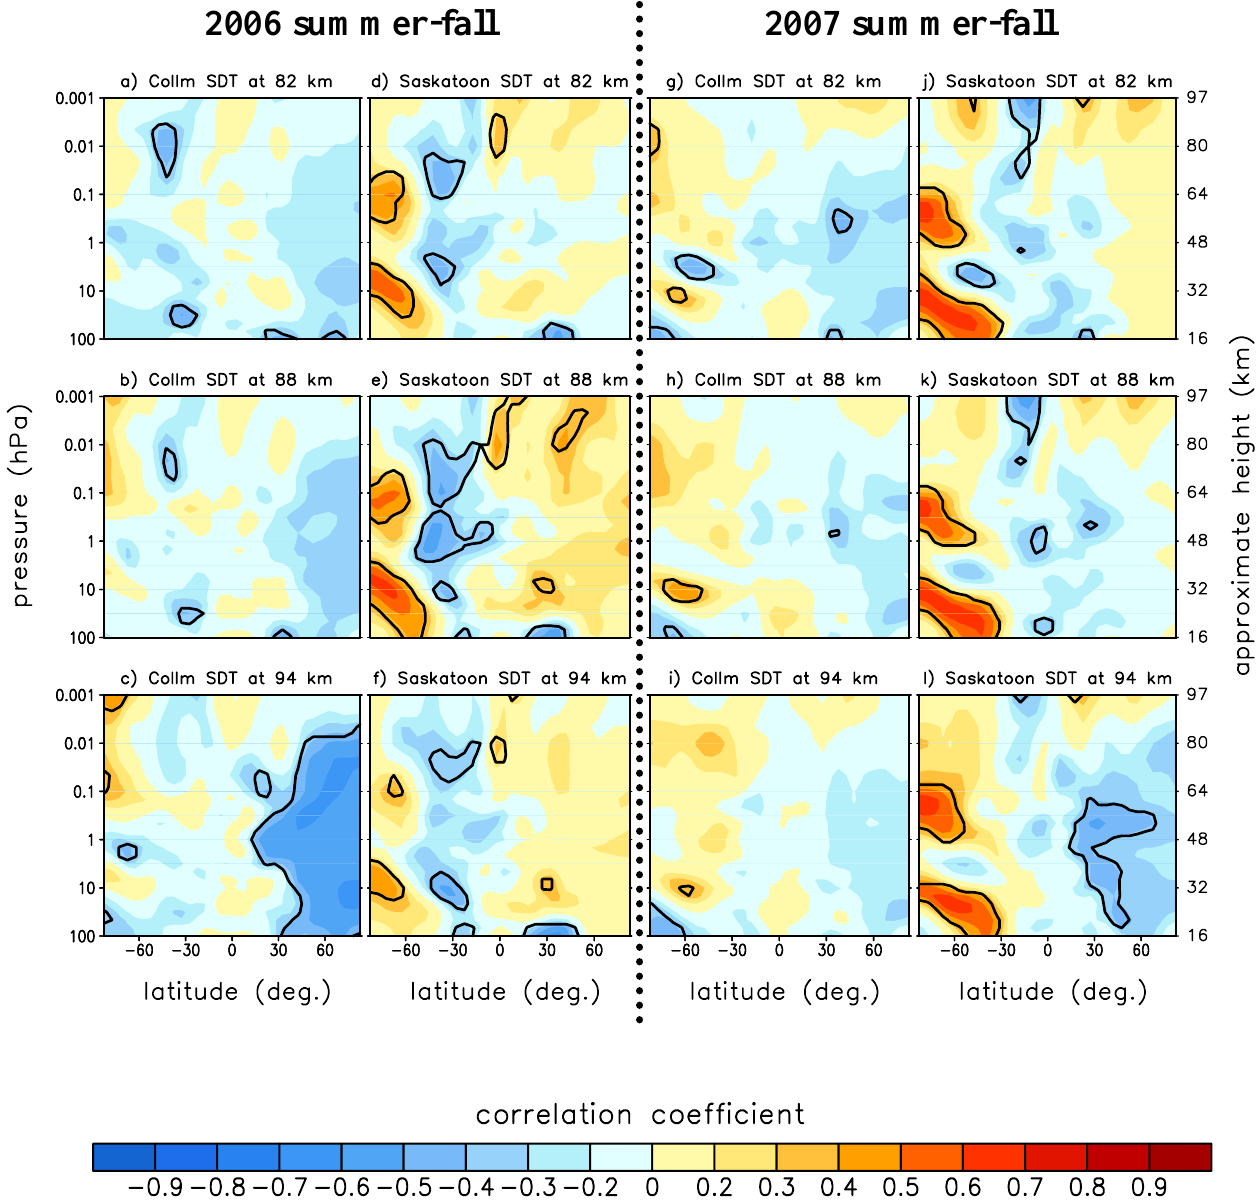
Fig. 4. Correlation coefficients between the stationary planetary wave 1 amplitude at each latitude/pressure with the amplitudes of meridional semidiurnal tides observed at Collm (51 ◦ N, 13 ◦ E) and Saskatoon (52 ◦ N, 253 ◦ E) for 30 June–27 October, 2006 and 2007. Otherwise details are as in Fig.